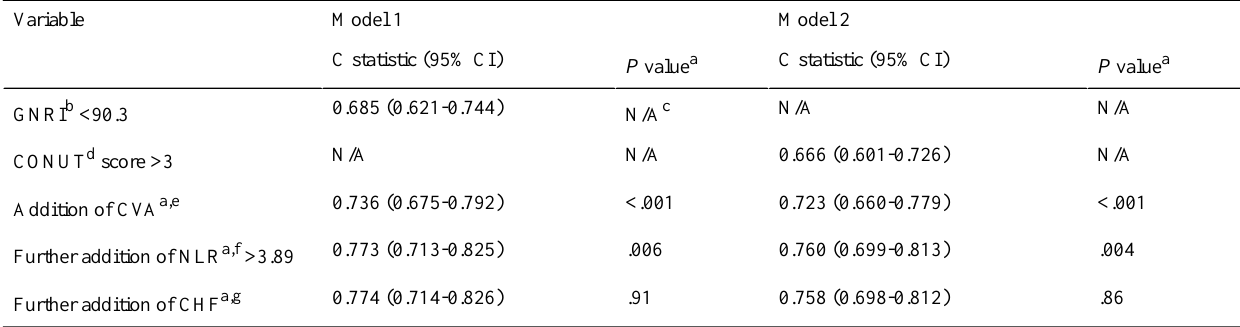
Table 4. C statistics for the prediction of 2-year